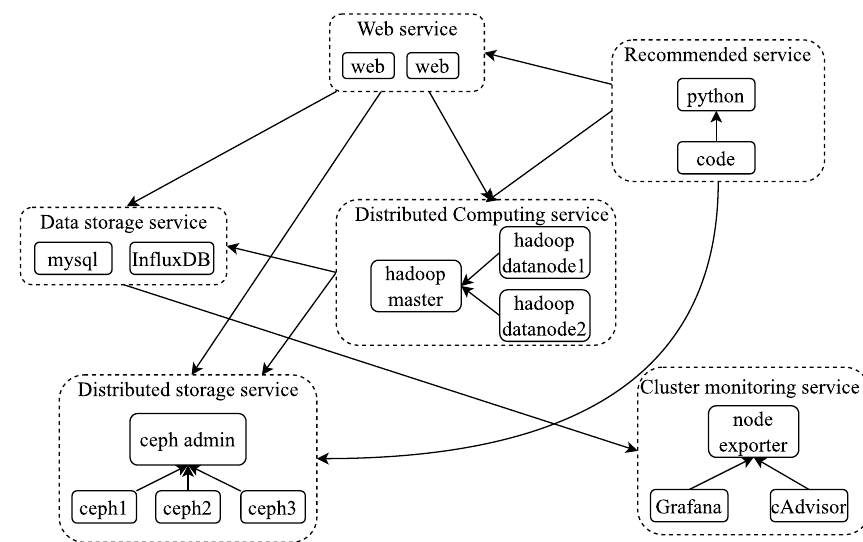
Fig. 9 The services configuration in the experiments